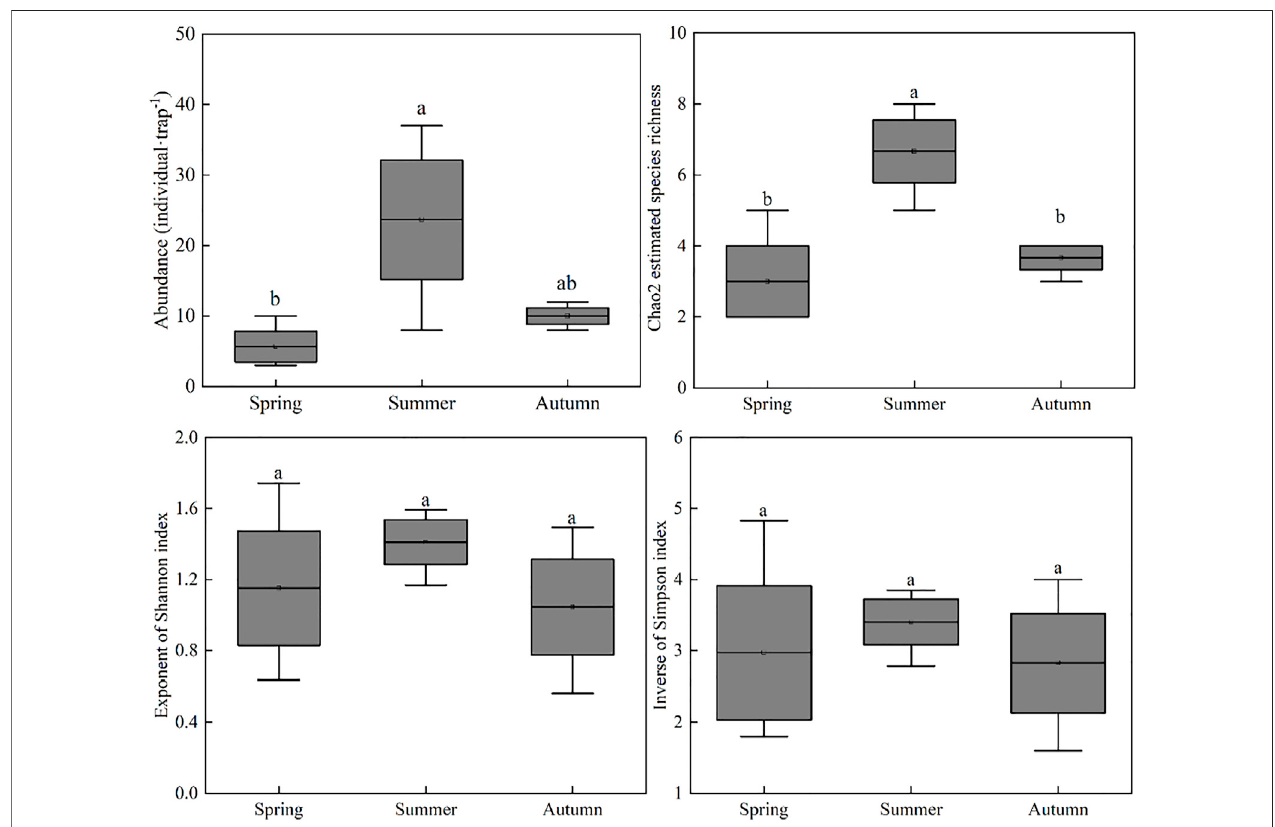
FIGURE3| Theboxplotrepresentsthedistributionofabundance,Chao2estimatedspeciesrichness,exponentofShannonindexandinverseofSimpsonindexof soil microarthropod between Spring, Summer, and Autumn in Urad desert steppe (Mean ± SE). Lowercase letters indicate signi fi cant differences between seasons (p < 0.05).